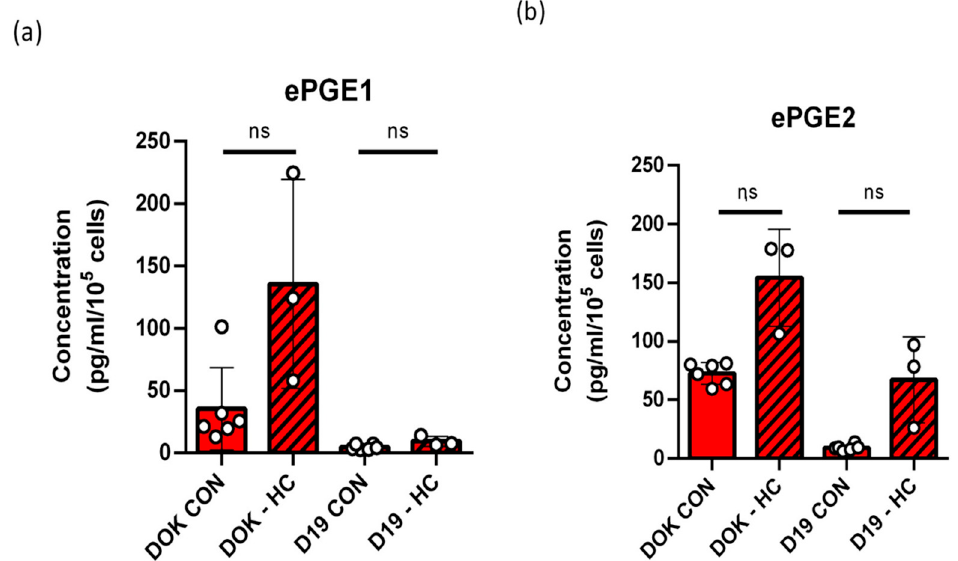
Figure 9. ePGE expression in IPPOL keratinocytes is repressed by hydrocortisone. ( a ) ePGE1 levels and ( b ) ePGE2 levels in DOK and D19 cells where hydrocortisone (HC) was removed from the culture medium for 3 weeks ( − HC striped bars). ns = not significant by Welch’s t test. CON = control ( n = 6 independent cultures); − HC = derived of hydrocortisone for 3 weeks ( n = 3 independent cultures).